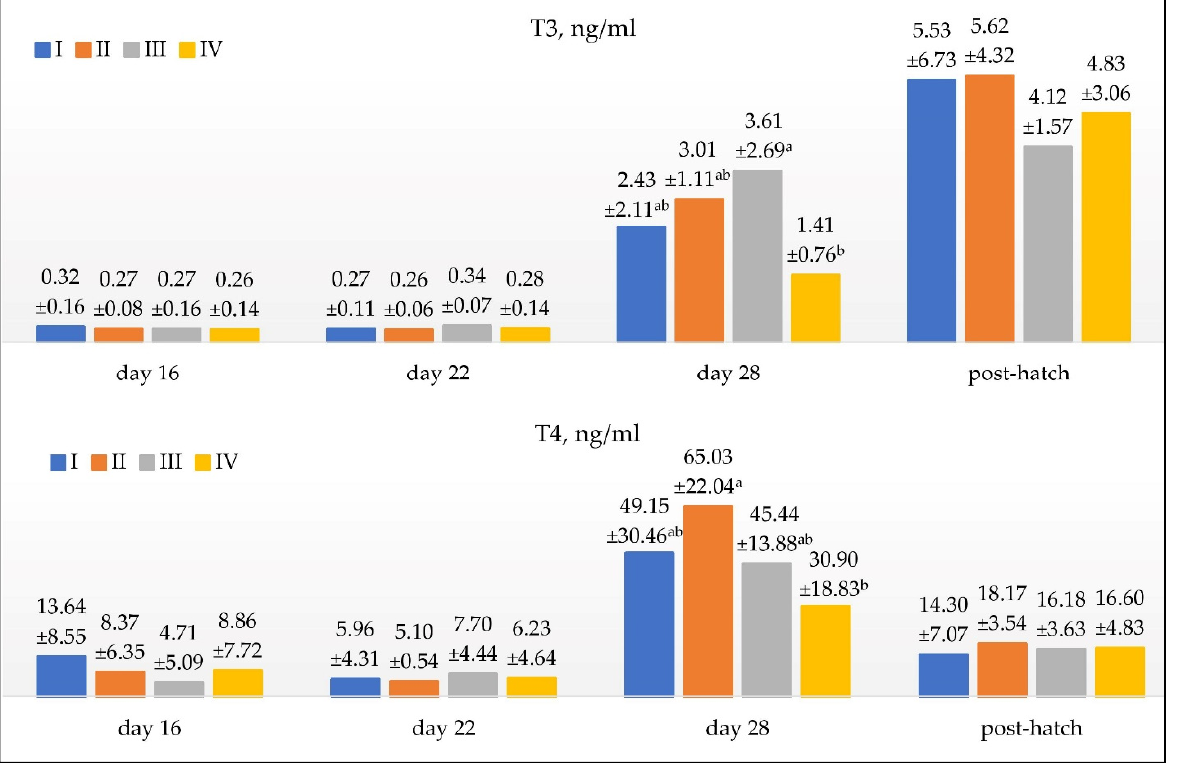
Figure 1. The concentration of triiodothyronine (T3) and thyroxine (T4) in the blood serum of embryos and goose chicks depends on the age of the parent flock. Values are the mean ± SD (standard deviation) a,b ; mean values marked with different letters differ significantly; p < 0.05; I, 1-year-old geese; II, 2-year-old geese; III, 3-year-old geese; IV, 4-year-old geese; n = 15/per group; n = 8/per group post-hatch.